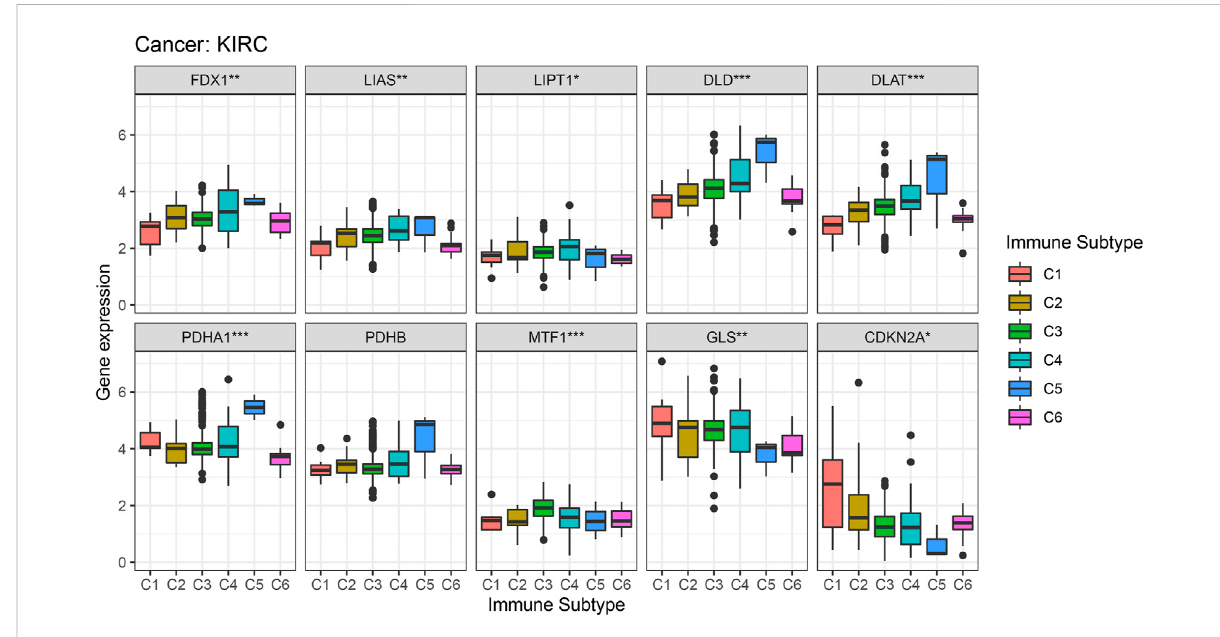
FIGURE 9 Correlation analysis between the expression of cuproptosis-associated genes and different immune subtypes in Kidney renal clear cell carcinoma